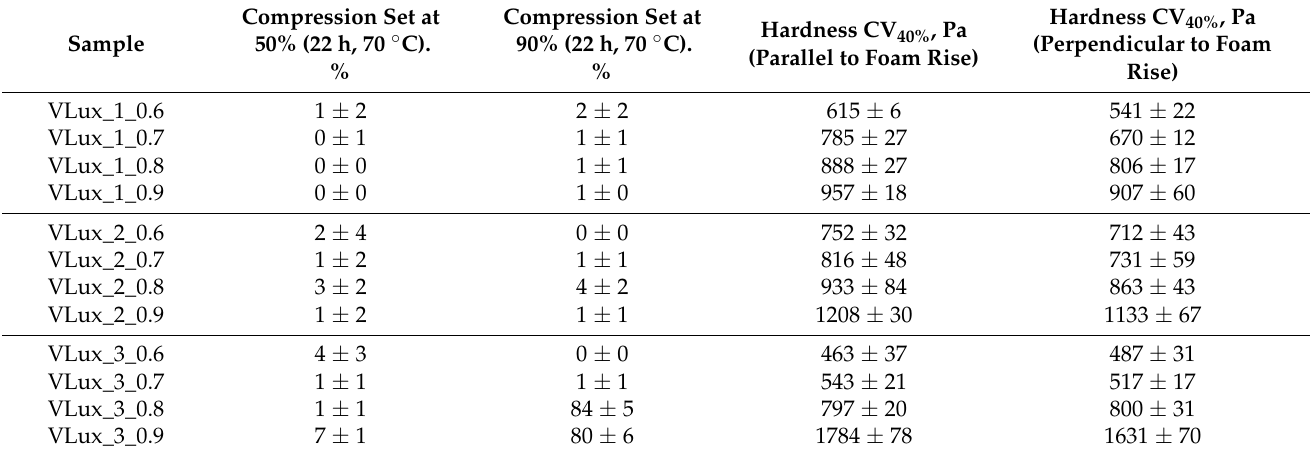
Table 6. Compression set at 50% and 90% with compression stress value for different INCO and water content